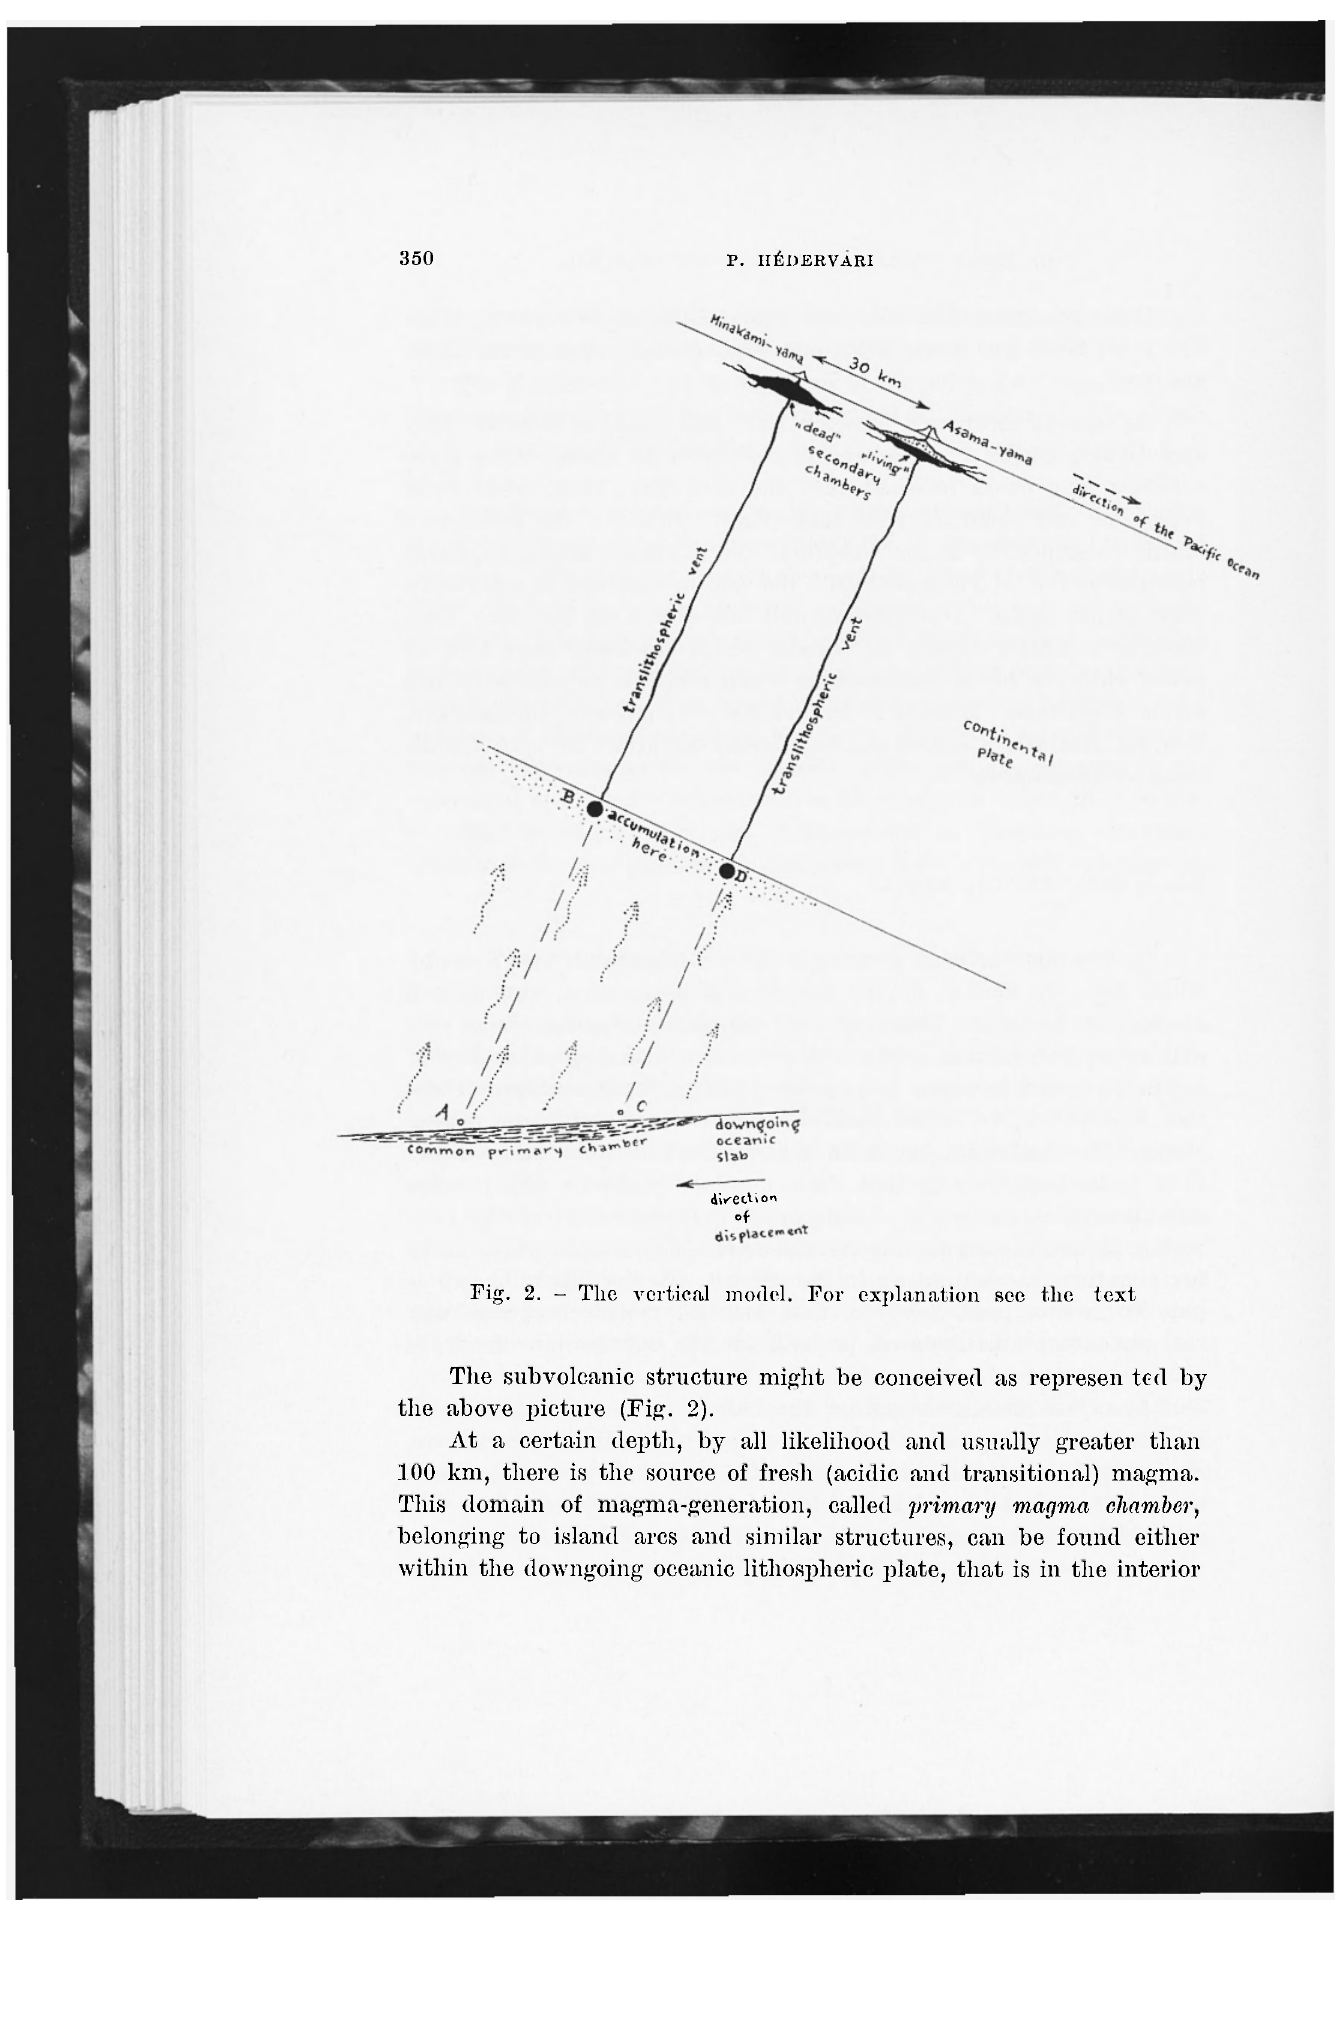
Fig. 2. - Tlie vertical model. For explanation sec